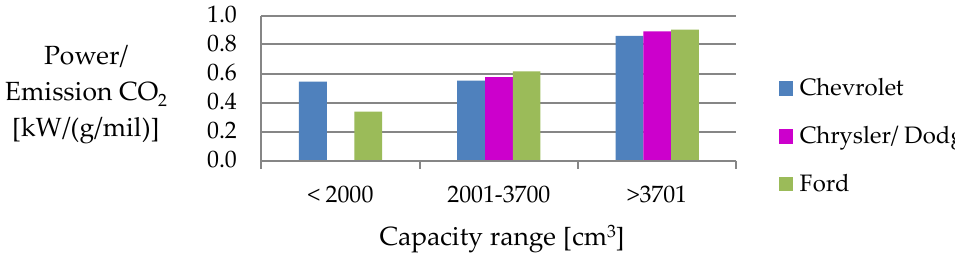
Figure 18. Ratio of engine power to combustion in individual engine capacity ranges among American car brands. Source: Developed own. car brands. Source: Developed own. American car brands. Source: Developed own.